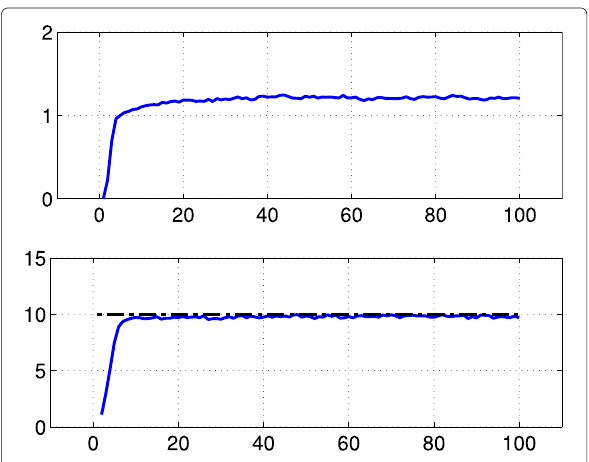
Fig. 3 Arbitrarily 100 samples of the simulated chains: granularity coefficient β (top) and noise parameter γ n